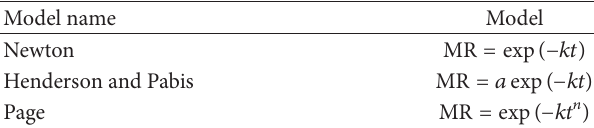
Table 1: Mathematical models used for drying curves [38–43].